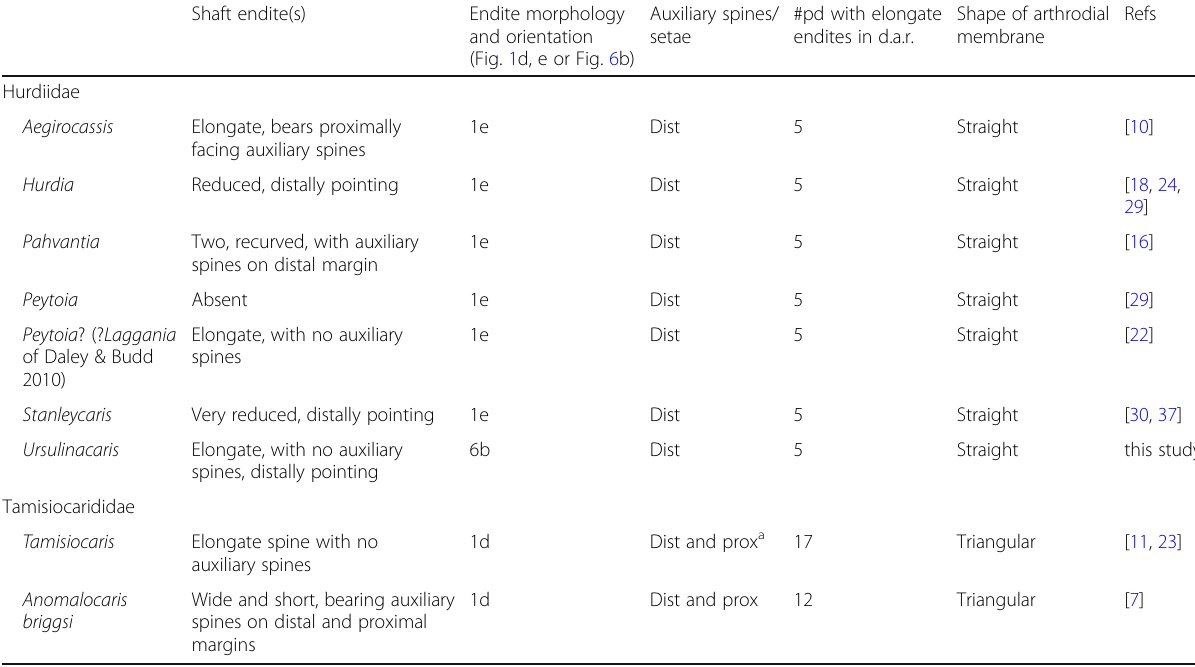
Table 1 Comparison of frontal appendage characters in select hurdiid and tamisiocaridid genera Shaft endite(s) Endite morphology